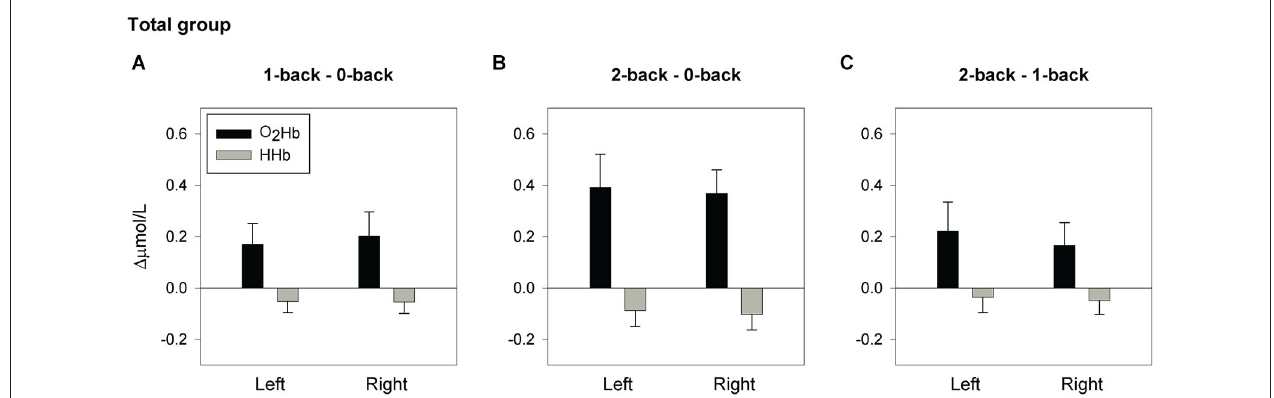
FIGURE 2 | Hemodynamic concentration changes in the total sample of older adults . Mean ( ± SEM) changes of [O 2 Hb] and [HHb] in the left and right hemisphere for the spatial 1-back minus 0-back contrast (A) , 2-back minus 0-back contrast (B) , and 2-back minus 1-back contrast (C)